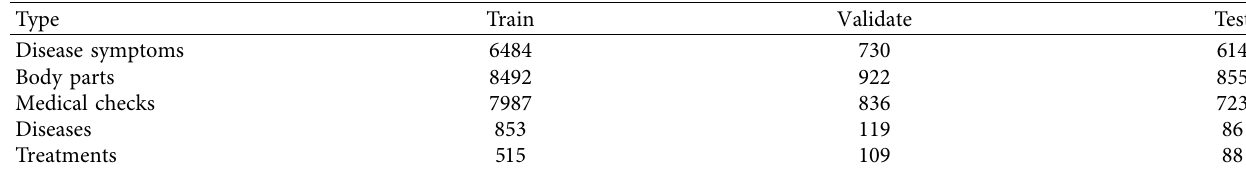
Table 2: The statistical results of different entities in the dataset.